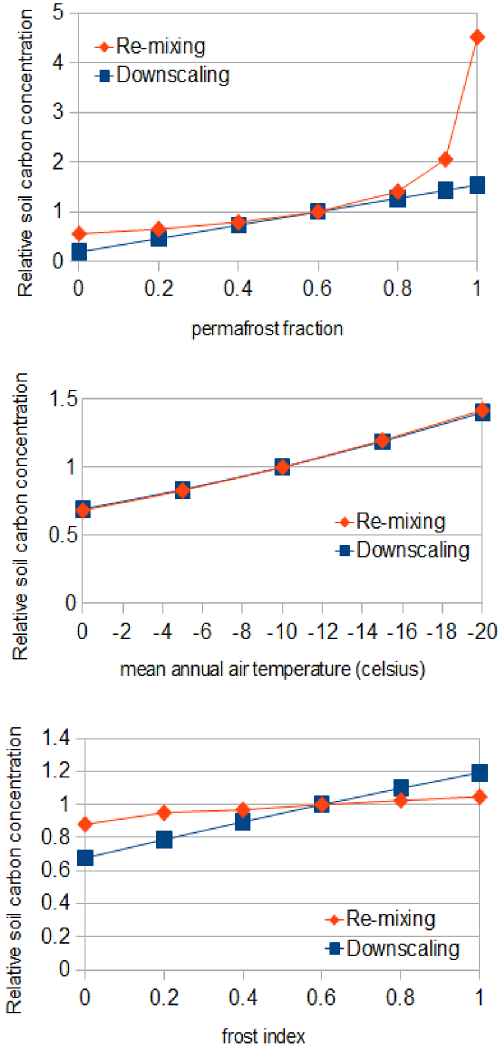
Figure A1. 1-D model output to compare the performance of the remixing (diamonds) and the sub-grid (squares) approaches. Top: MAT and frost index are constant, permafrost fraction is variable. Middle: frost index and permafrost fraction are constant, MAT is variable. Bottom: permafrost fraction and MAT are constant, frost index is variable. Input to soils from plant mortality and rainfall are constant for all.